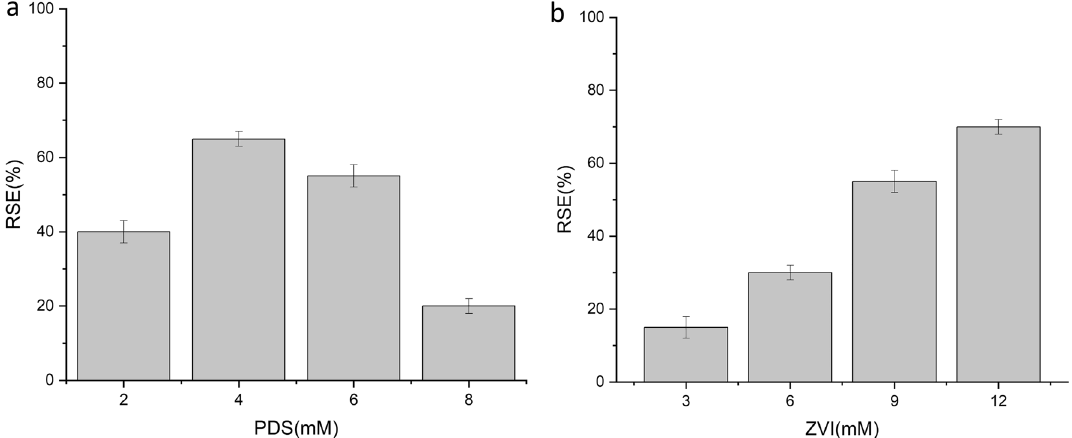
tion stoichiometric efficiency (RSE) calculated for the different PDS concentration. Experimental conditions: [AMR] [PDS] = 4 mM, Temp. = 25 °C, pH 0